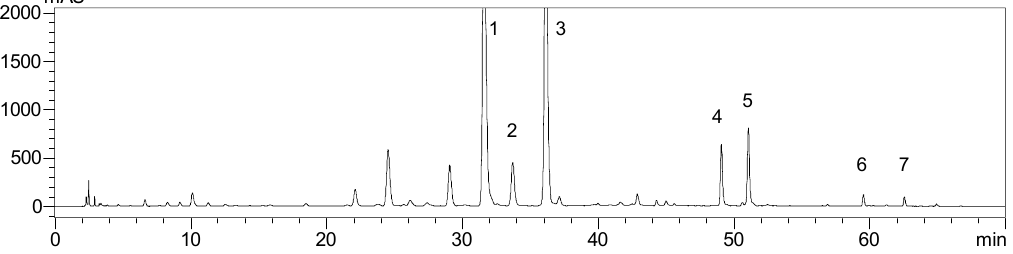
Figure 2. HPLC profile of the ethyl acetate extract of C . aurantium dried immature fruits and compound-identified peaks: naringin ( 1 ); hesperidin ( 2 ); neohesperidin ( 3 ); naringenin ( 4 ); hesperetin ( 5 ); nobiletin ( 6 ); and tangeretin ( 7 ).